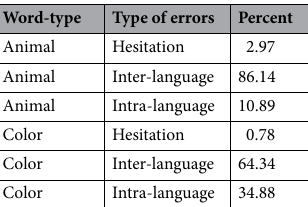
Table 2. Type of errors produced. Errors from within each word-type sum up to 100%.